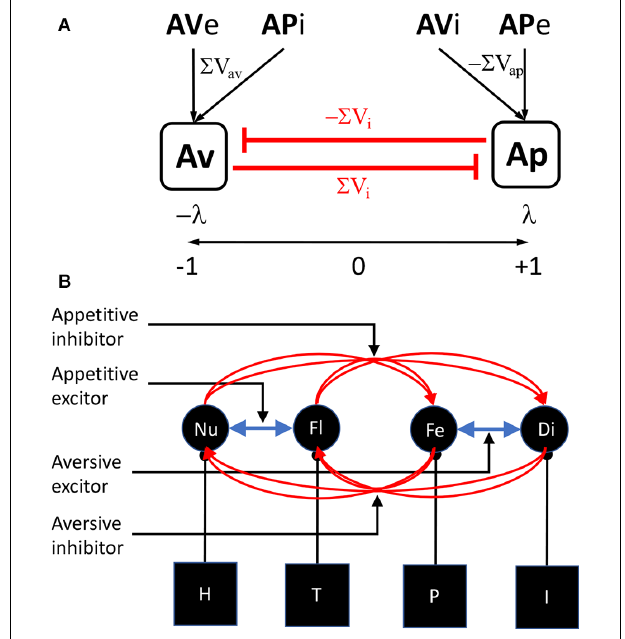
FIGURE 4 | Models of appetitive-aversive interaction. (A) An appetitive-aversive continuum account according to which appetitive ( λ ) and aversive ( − λ ) events are combined on a substrate to generate the prediction error term for appetitive-aversive interactions. The associative strength of aversive excitors and appetitive inhibitors (AVe+APi) sum ( Σ V av ) to drive aversive predictions, aversive prediction errors ( − λ + Σ V av ) and inhibition of the appetitive system ( Σ Vi) whereas the associative strength of appetitive excitors and aversive inhibitors (APe+AVi) sum ( Σ V ap ) to drive appetitive predictions, aversive prediction errors ( λ − Σ V ap ) and inhibition of the aversive system ( − Σ Vi). (B) A motivational account on which specific motivational systems combine to emulate appetitive and aversive systems and drive inhibitory connections with systems to which they are not linked. In this example, a hunger (H)—nutrient (Nu) system joins a thirst (T)—fluid (Fl) system to generate appetitive activity and a pain (P)—fear (Fe) system joins an illness (I)—disgust (Di) system to generate aversive activity (blue arrows) and these pairs of systems maintain individual inhibitory links (red arrows) to generate appetitive-aversive